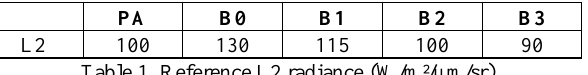
Table 1. Reference L2 radiance (W/m²/µm/sr)